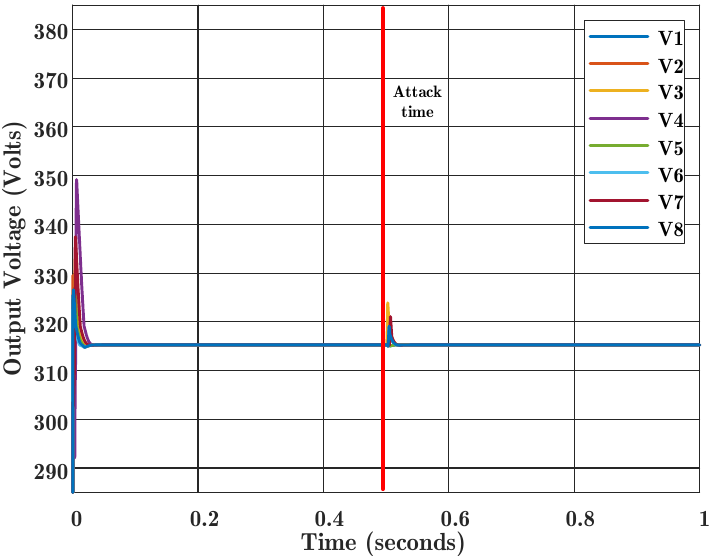
Figure 7. Proposed consensus algorithm results in the presence of false data injection attack at time 0.5 s. The values of V 1 to V 8 are output voltages for Agent 1 to 8,